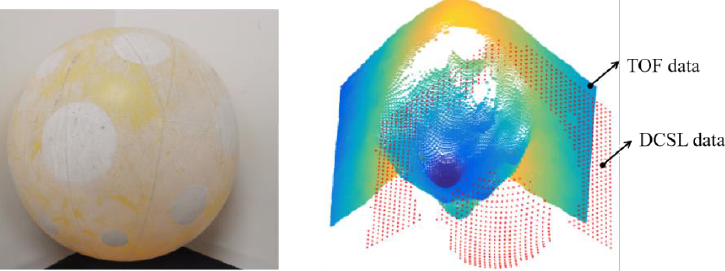
Figure 1. Comparison of a ball’s reconstruction results by TOF and DCSL. Note that the ball’s surface is of multi-reflective properties, and it was placed in a corner of the wall.